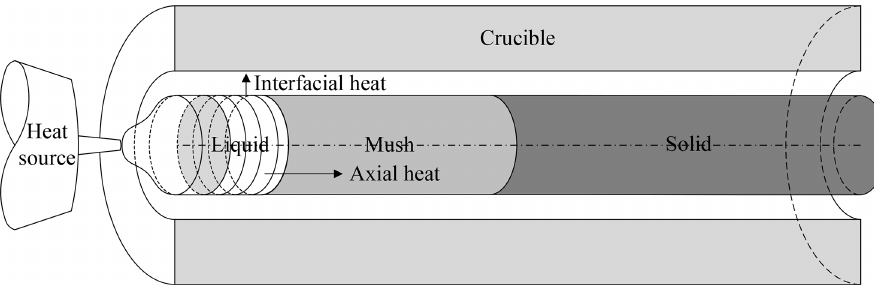
Figure 1. Schematic of scenario for a cylindrical rod.